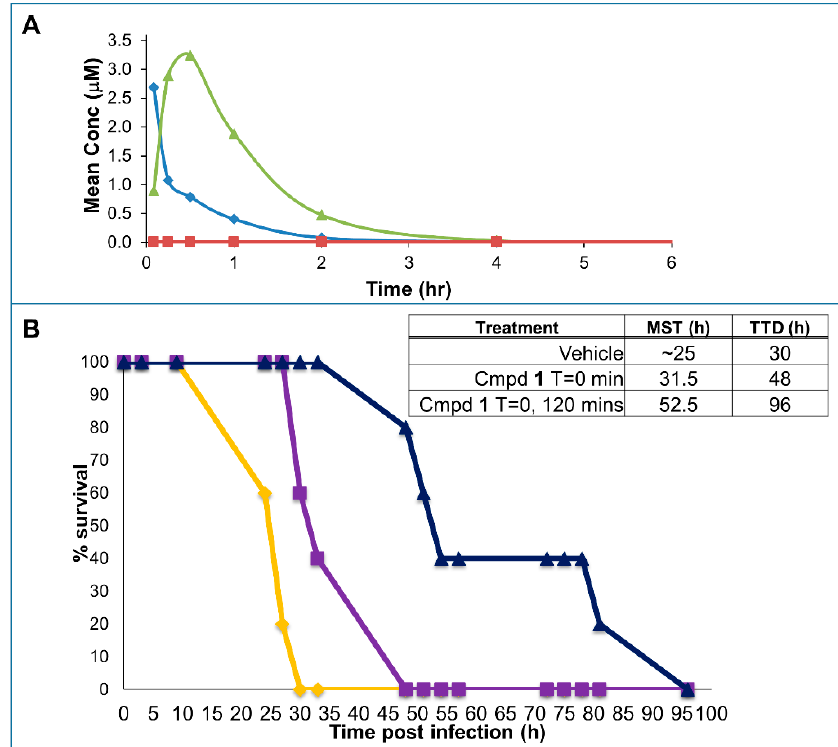
Figure 3. In vivo pharmacology and efficacy of compound 1 . ( A ) Preliminary pharmacokinetics